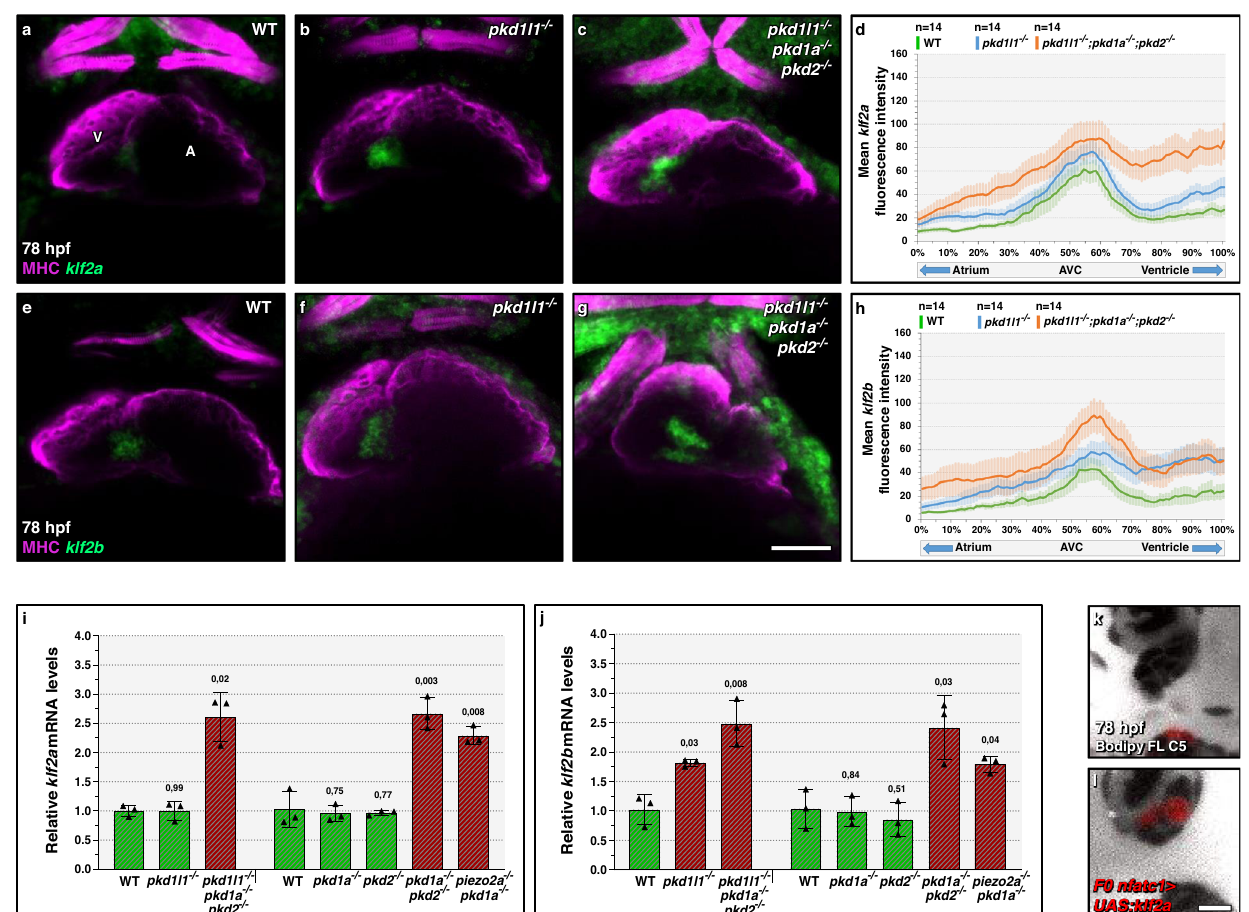
Fig. 5 | Pkd and Piezo members repress klf2 expression in the atrioventricular canal.a – c , e – g Confocalprojectionsof78hpfwild-type( a , e ), pkd1l1 mutant( b , f ), and pkd triple mutant ( c , h ) hearts stained for MHC, and klf2a ( a – c ), or klf2b ( e – g ) expression; ventral views, anterior to the top, ventricle (V) on the left, and atrium (A) on the right. d , h klf2a ( d ) and klf2b ( h ) mean fl uorescence intensity along the heart tube in 78 hpf wild-type, pkd1l1 mutant, and pkd triple mutant larvae. i , j Relative mRNA levels of klf2a ( i ) and klf2b ( j ) in78hpfwild-type, pkd1l1 mutant, pkd1a mutant, pkd2 mutant, pkd1a; pkd2 double mutant, pkd triple mutant, and piezo2a; pkd1a double mutant dissected hearts; n =3 biologically independent samples; Ct values are listed in Supplementary Data 1. k , l Confocal imaging of 78